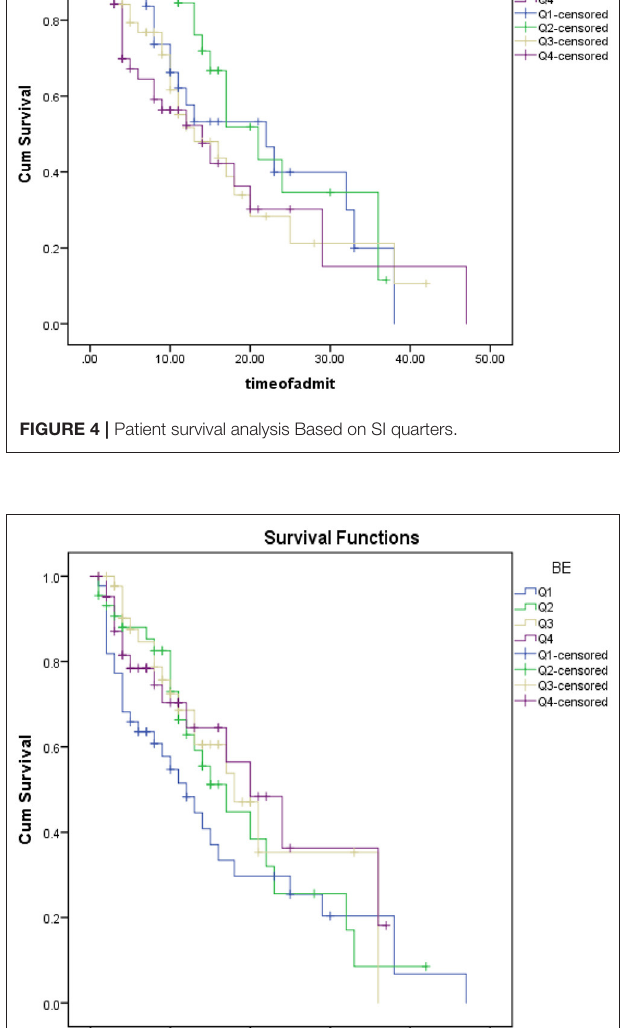
significant difference in AUC of RASI and SI (chi 2 (1) = 2.09, P = 0.1480). RASI scoring system with 97% sensitivity and 96% specificity predicted mortality with a 1.285 cut-off. The BE scoring system, with a sensitivity of 98.8% and a specificity of 97.8%, predicted mortality with a cut-off of 16.9. Cox analysis showed that none of the variables were associated with mortality ( P > 0.05); Except for hospitalization in the intensive care unit, which was significantly identified as a risk factor for death with a risk ratio of 6.723 ( p = 0.002) ( Table 4 ).